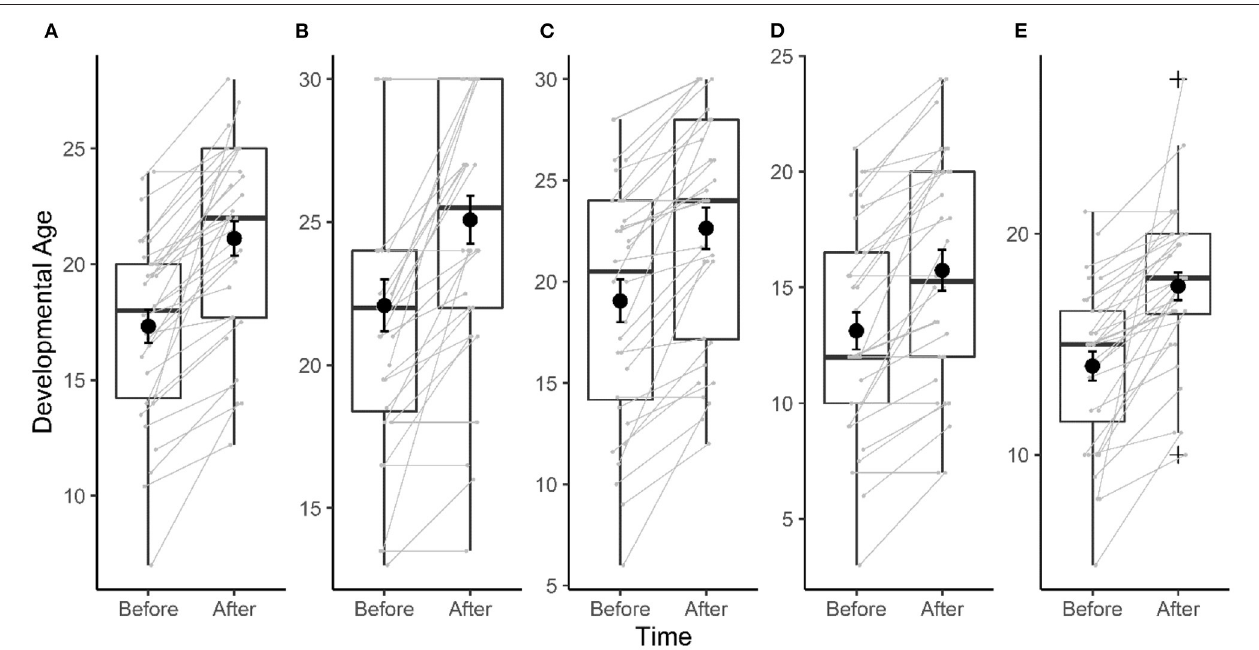
FIGURE 4 | Evolution of developmental age assessed with Brunet–Lézine before and after 9 months of therapy. (A) Global developmental age (GDA). (B) Postural developmental age (PDA). (C) Oculo-manual coordination developmental age (CDA). (D) Language developmental age (LDA). (E) Sociability developmental age (SDA). Black dot and error bar represent mean and SEM. Gray dot and connecting lines represent individual